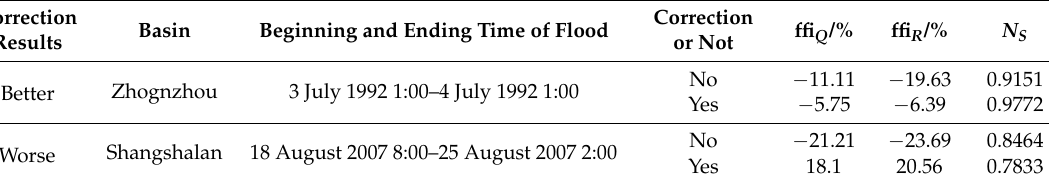
Table 14. Statistics of typical under-estimated floods.